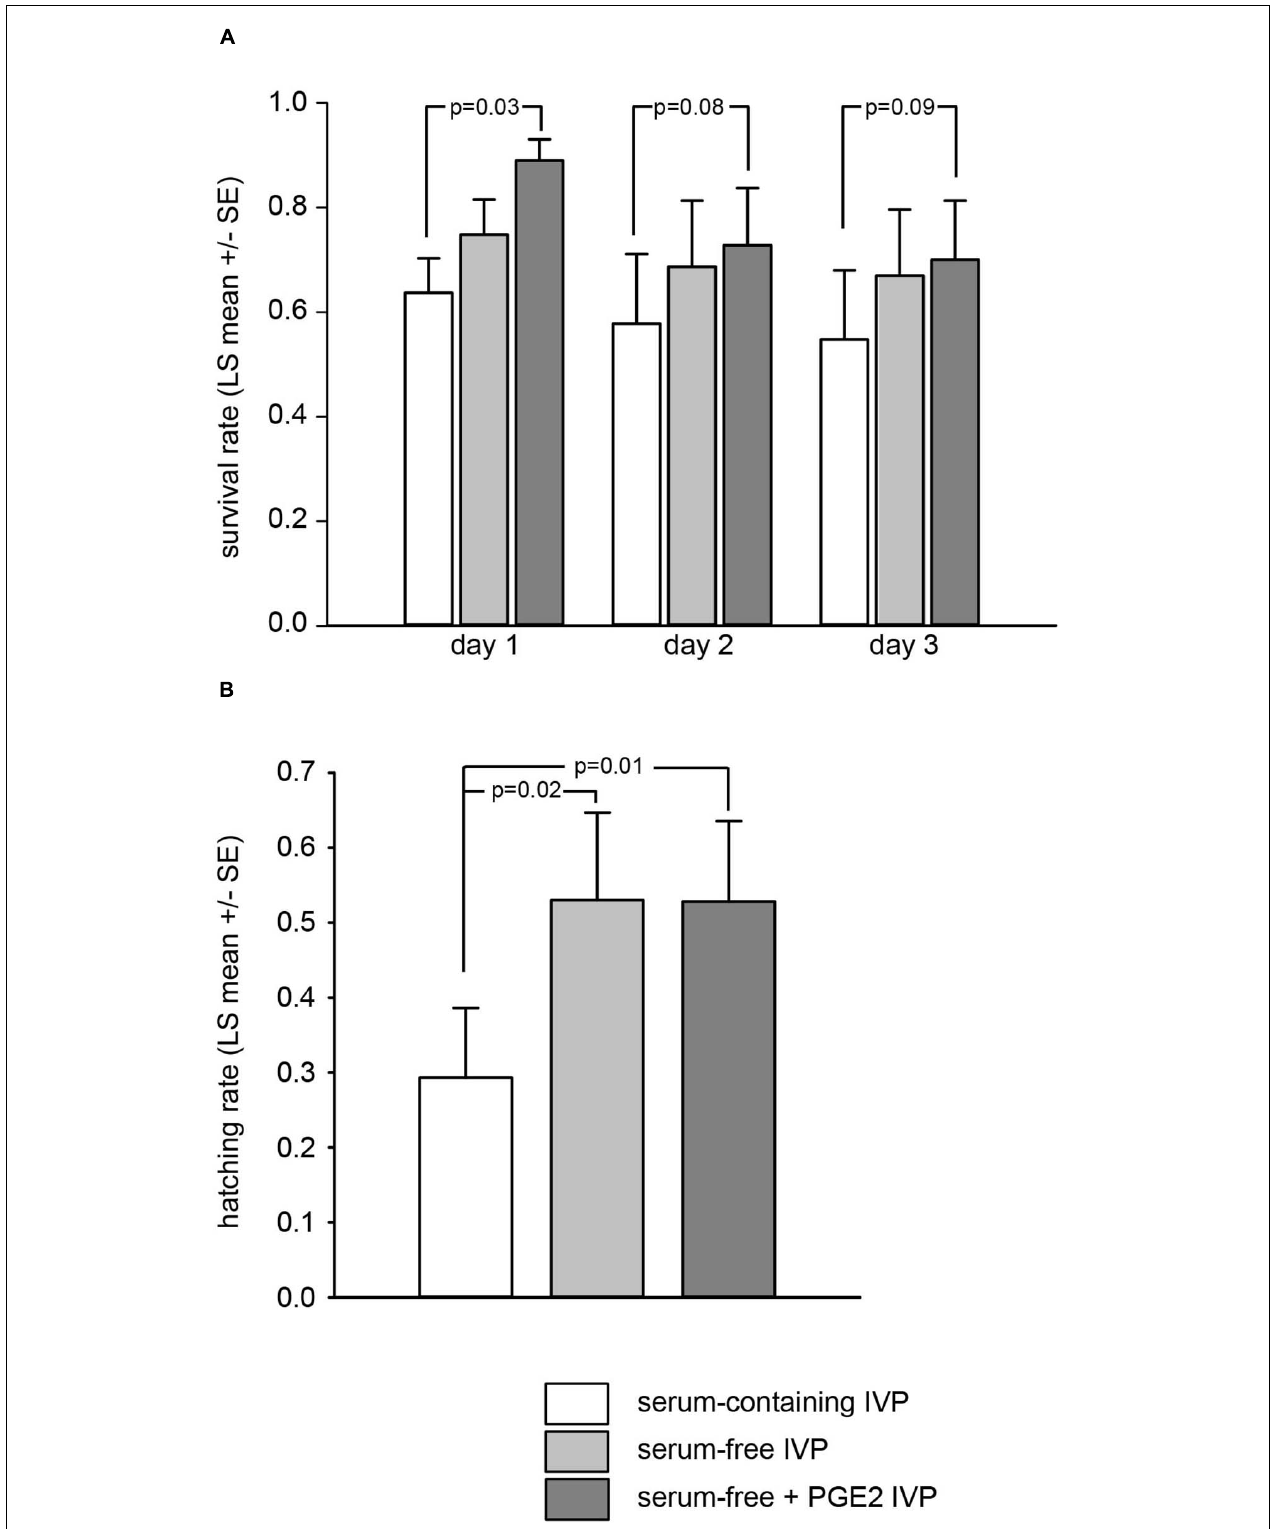
FIGURE 1 | Culture conditions used during the in vitro production of bovine blastocysts alter embryo survival on days 1, 2, and 3 (A) and hatching rate on day 3 (B) after thawing. Proportion of embryos relative to the total number of thawed blastocysts. Values are represented as LS mean ± SE.